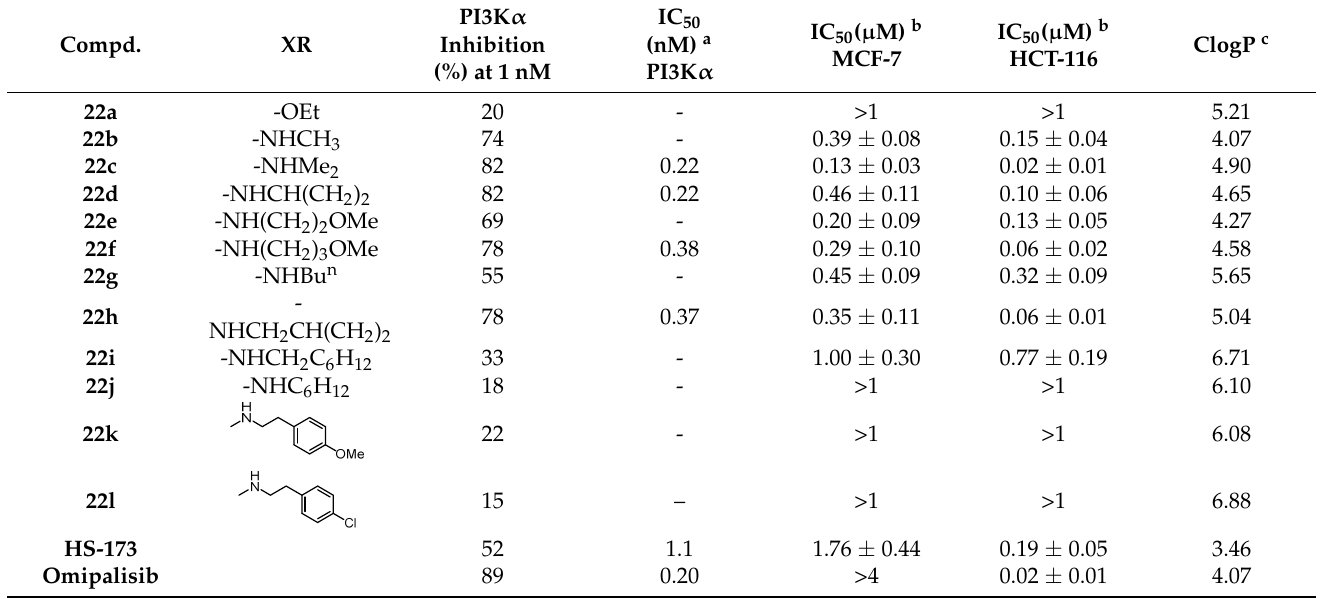
Table 3. Enzyme inhibition of PI3K α and antiproliferative activity against MCF-7 and HCT-116 cells by 22a–l .